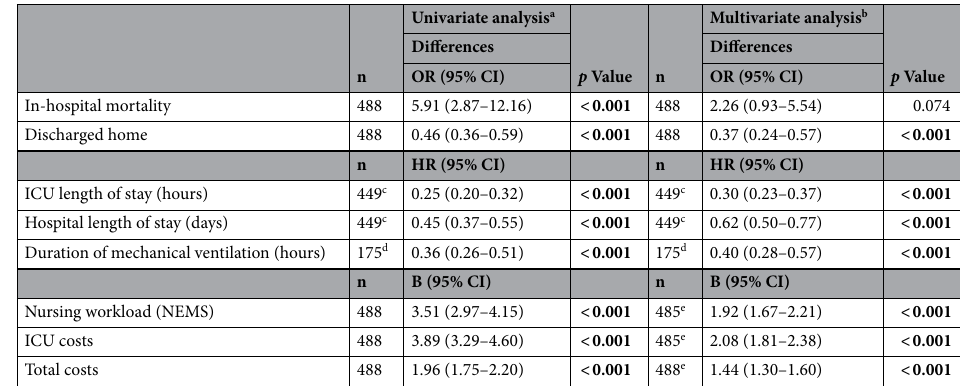
Table 3. Outcome of critically ill patients with malignancy: Results from univariate and multivariate analysis. B regression coefficient, CI confidence interval, HR hazard ratio, ICU intensive care unit, NEMS nine equivalents of nursing manpower use score, OR odds ratio. a Unadjusted differences between the groups delirium vs. no delirium described as OR, HR from univariate Cox regression and regression coefficients from linear regression, each with its 95% confidence intervals. b Adjusted differences between the groups delirium vs. no delirium described as OR from multivariate binary logistic regression, HR from multivariate Cox regression and adjusted regression coefficients from multiple linear regression, each with its 95% confidence intervals. Multivariate models incorporated following covariates: Sepsis, shock, emergency admission, Simplified Acute Physiology Score II (SAPS II), age and Charlson Comorbidity Index ecxcept the multivariate binary logistic regression of in-hospital mortality which incorporated only sepsis, shock and SAPS II as covariates. Due to nonproportionality in multivariate Cox regression, SAPS II was entered as time-varying covariate in the analysis of ICU and duration of mechanical ventilation, and SAPS II and age were entered as time-varying covariates in the analysis of hospital length of stay. Due to skewedness of ICU nursing workload and ICU and total cost data, the natural log transformation was performed in both linear and multiple linear regression. c Patients with in-hospital death excluded (n = 39). d Only patients with mechanical ventilation > 0 h included due to natural log transformation. e Patients with SAPS II = 0 lost due to natural log transformation of SAPS II (n = 3). HR < 1 indicates longer length of stay and longer mechanical ventilation. Bold indicates significance.